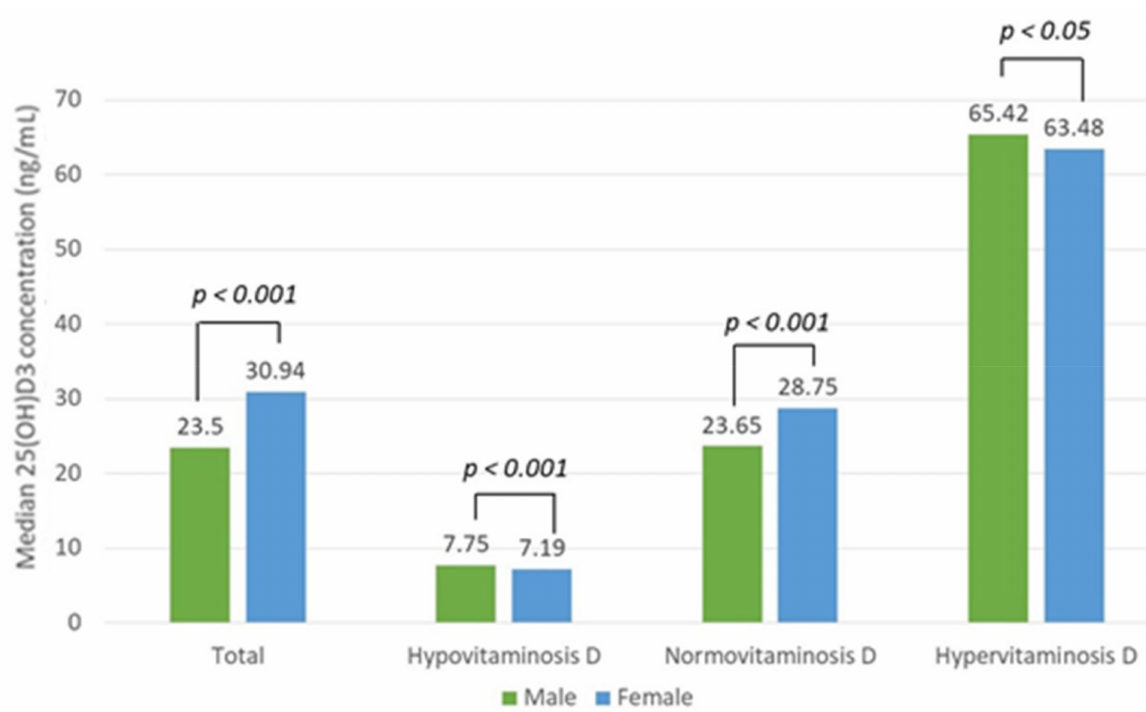
Figure 7. Median vitamin D (25(OH)D3) concentration difference between sexes in the total patient and hypo-, normo-, and hypervitaminosis D groups with the reference values of 10–50